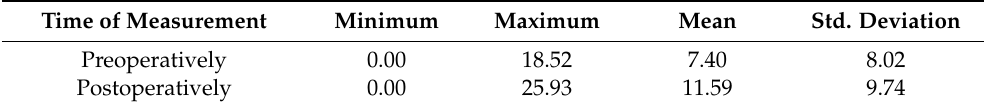
Table 1. Measurements of central dispersion for the mean number of microcracks in the root canal walls of moderately curved canals before and after instrumentation (n = 9).